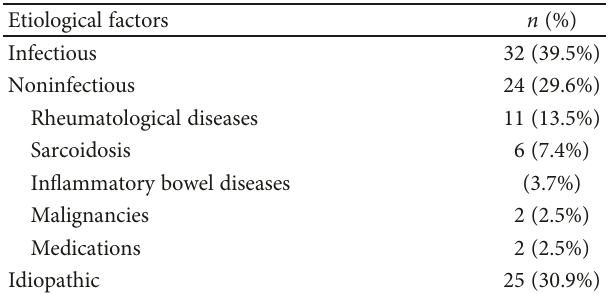
Table 2: Etiological factors in patients with erythema nodosum ( n = 81 ).